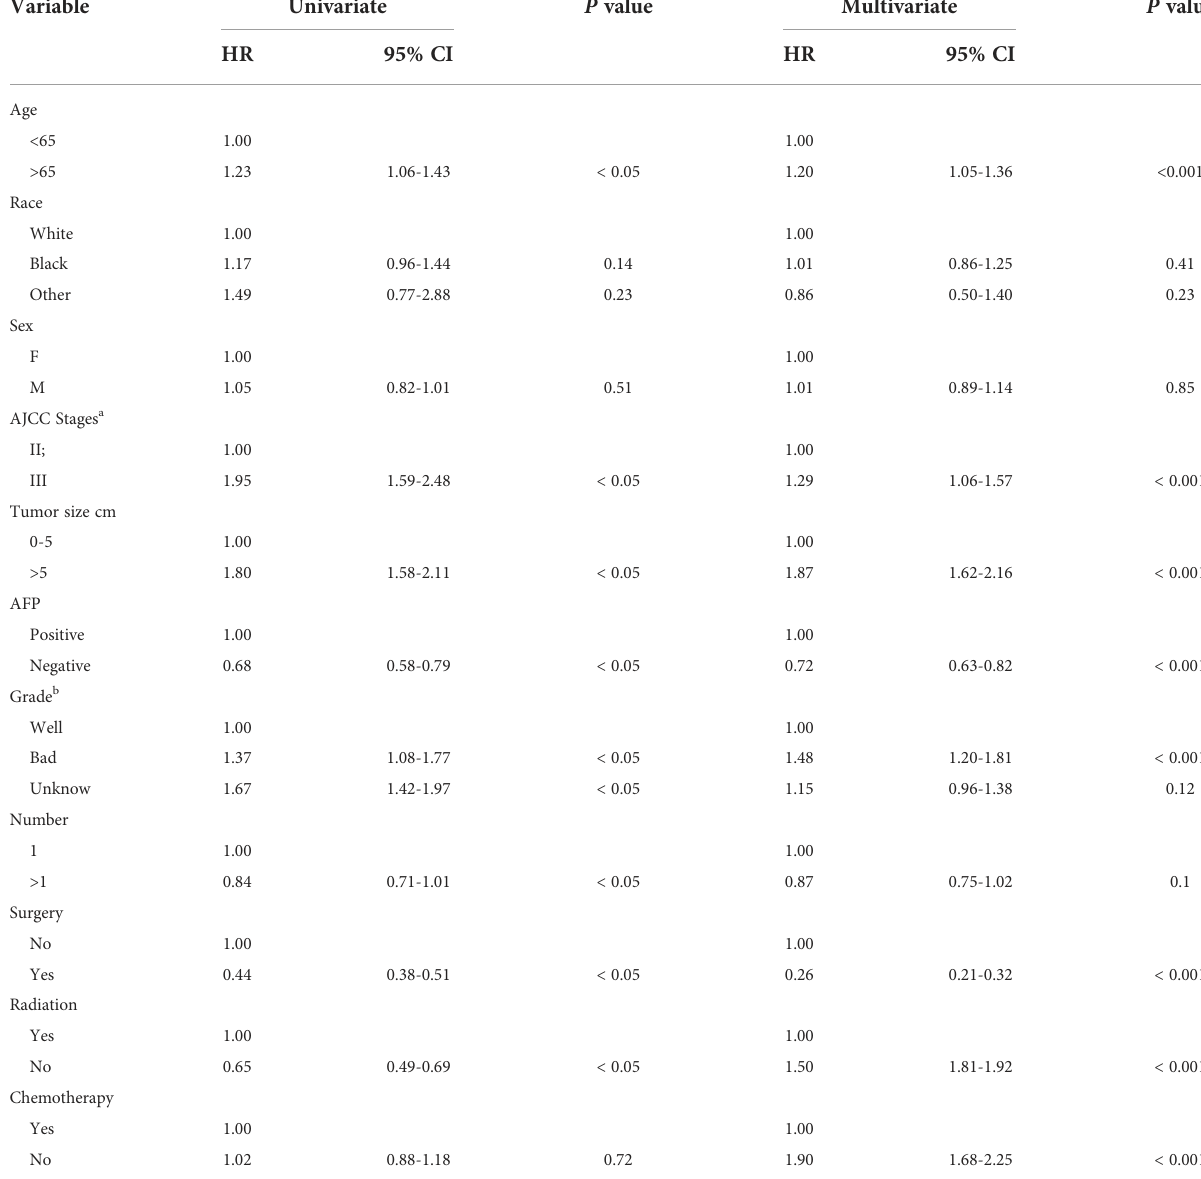
TABLE 2 Univariate and Multivariate Cox regression analyses of cancer-speci fi c survival. Variable Univariate P value Multivariate P value 95%